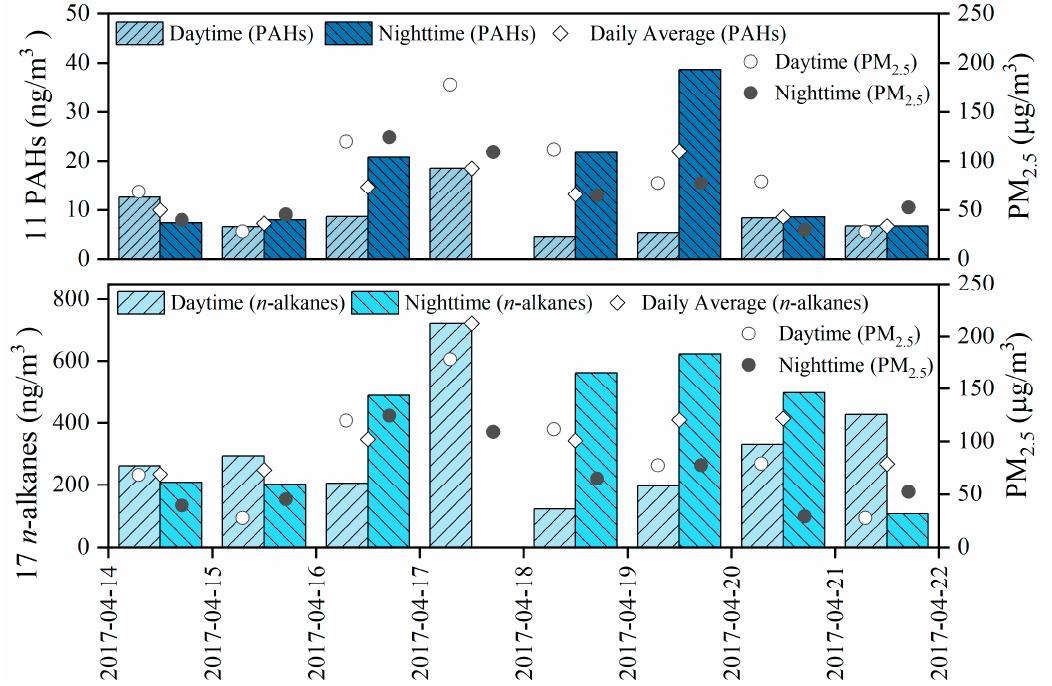
Figure 4. Daily and diurnal variation of mass concentrations of 17 n − alkanes and 11 PAHs in the study area during the monitoring period. Table 4. Comparison of 17 n − alkanes and BaP mass concentrations in PM 2.5 in Beijing with other